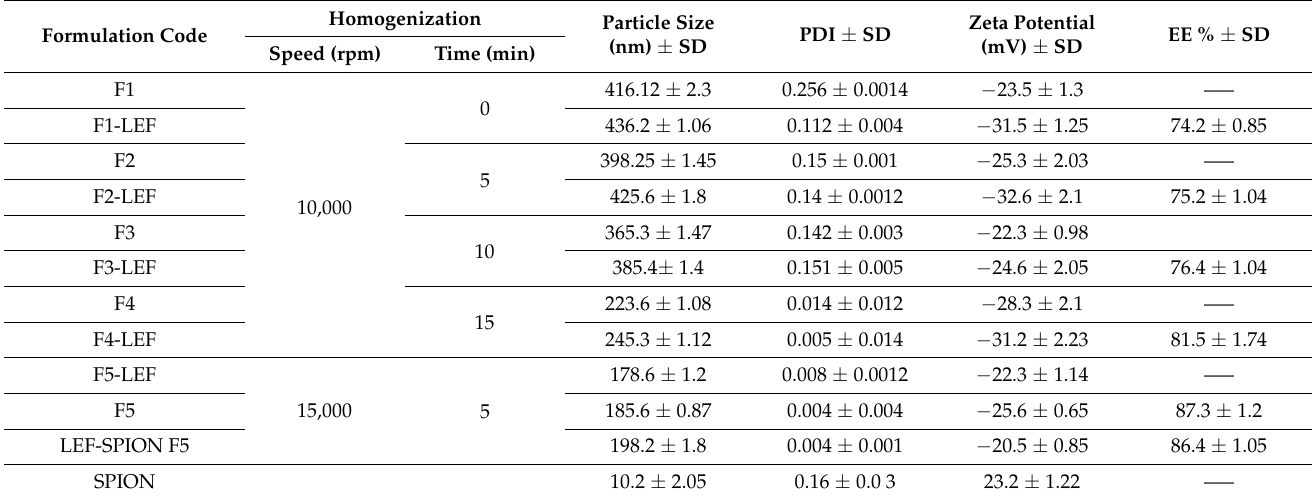
Table 2. Optimization and colloidal characteristics of blank, LEF EMLs and LEF-SPION EMLs using high-shear